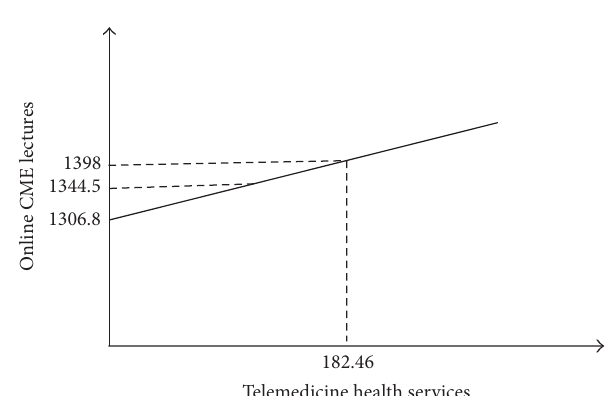
Figure 1: The relationship between telemedicine healthcare and the provision of online CME